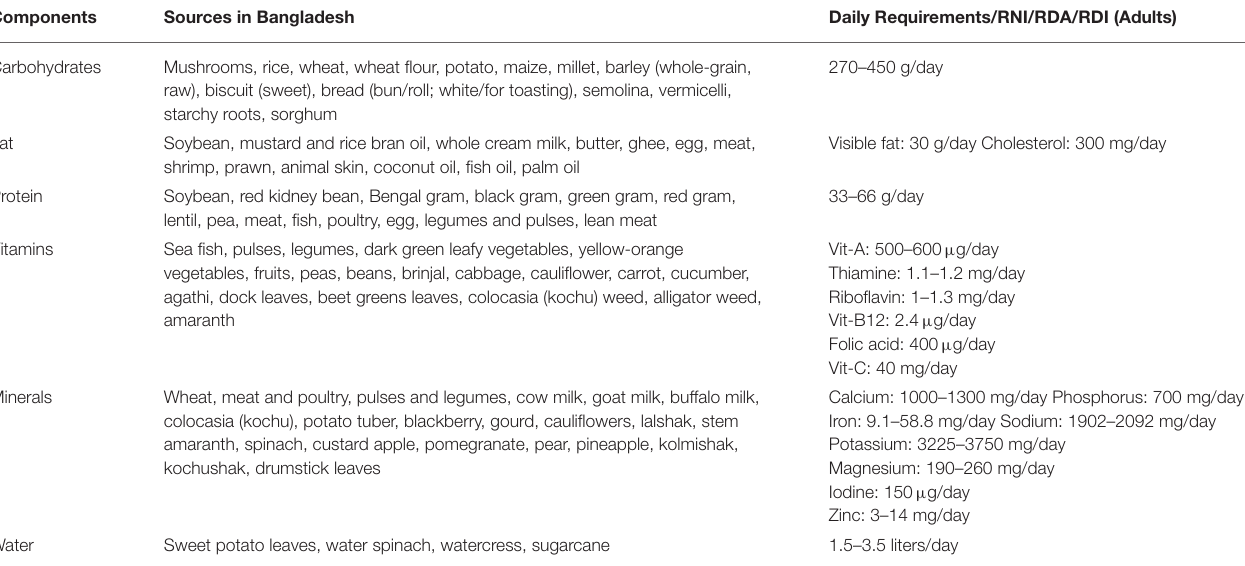
TABLE 3 | Basic components of nutrition and their sources in food types found in Bangladesh.